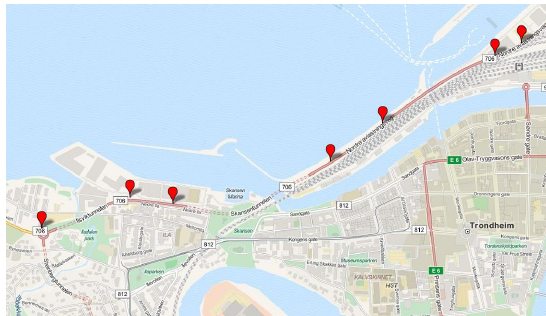
Figure 4: Location map of the positions surveyed in the areas out- side the tunnels to be used for the point cloud data matching pro- cess. Location of the points was selected to cover the test trajec- tory Røsjorde Lund (2013).